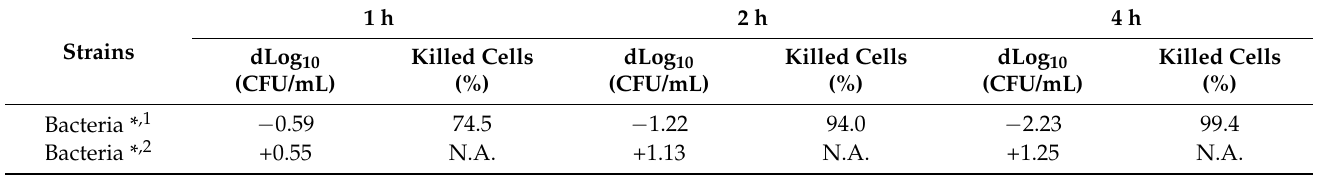
Table 7. Log 10 variation in the initial cell number of the tested bacteria expressed in CFU/mL and the percentage of killed bacteria when tested in mixture and exposed to R4 for 1, 2, and 4 h.